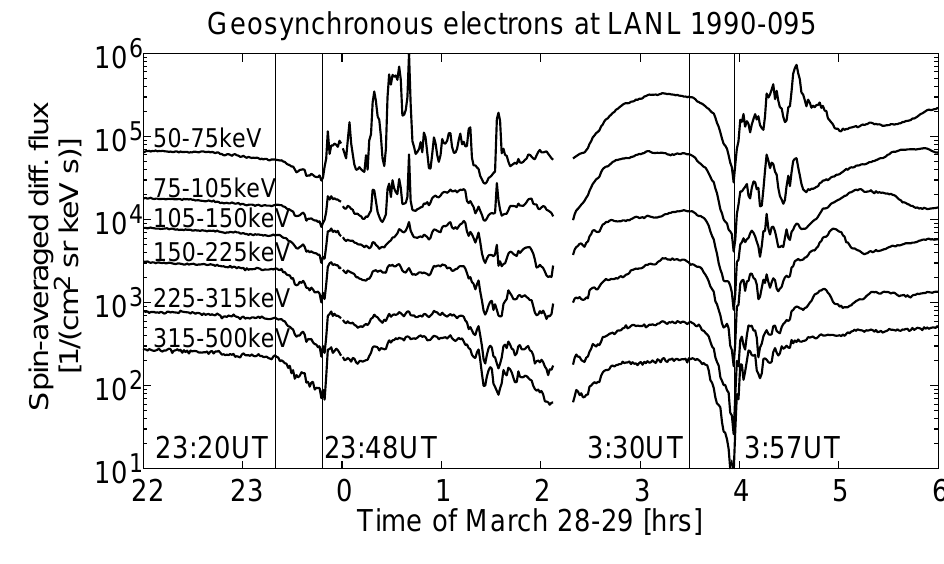
Fig. 3. Geostationary electron